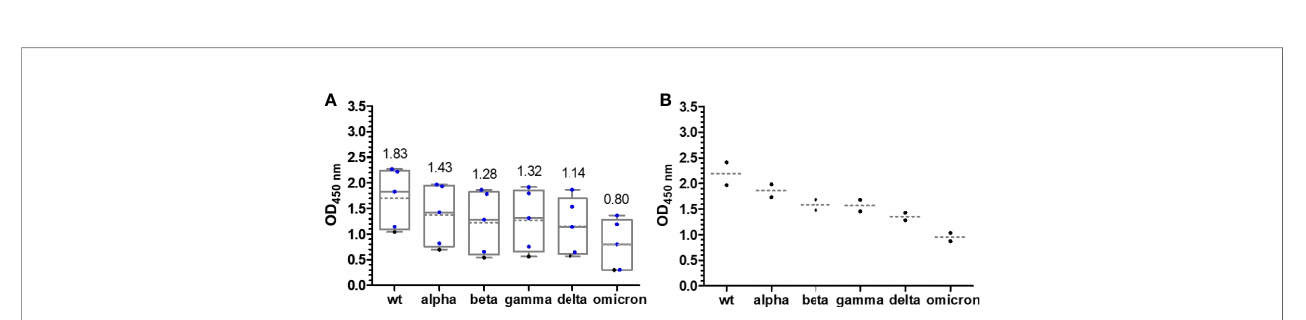
FIGURE 3 | Box plots of the OD 450 values obtained in an anti-RBD IgG ELISA and normalized OD 450 values of the inhibition assay using wild-type (A) , alpha (B) , beta (C) , gamma (D) , delta (E) , and omicron RBDs (F) . Serum and plasma samples were collected from 20 patients in the year 2015, which supposedly were not exposed to SARS-CoV-2 or SARS-CoV-1. The relationships of all samples between the two assays are indicated by lines of association. The median values are provided above the boxes and are additionally indicated as horizontal gray lines inside the